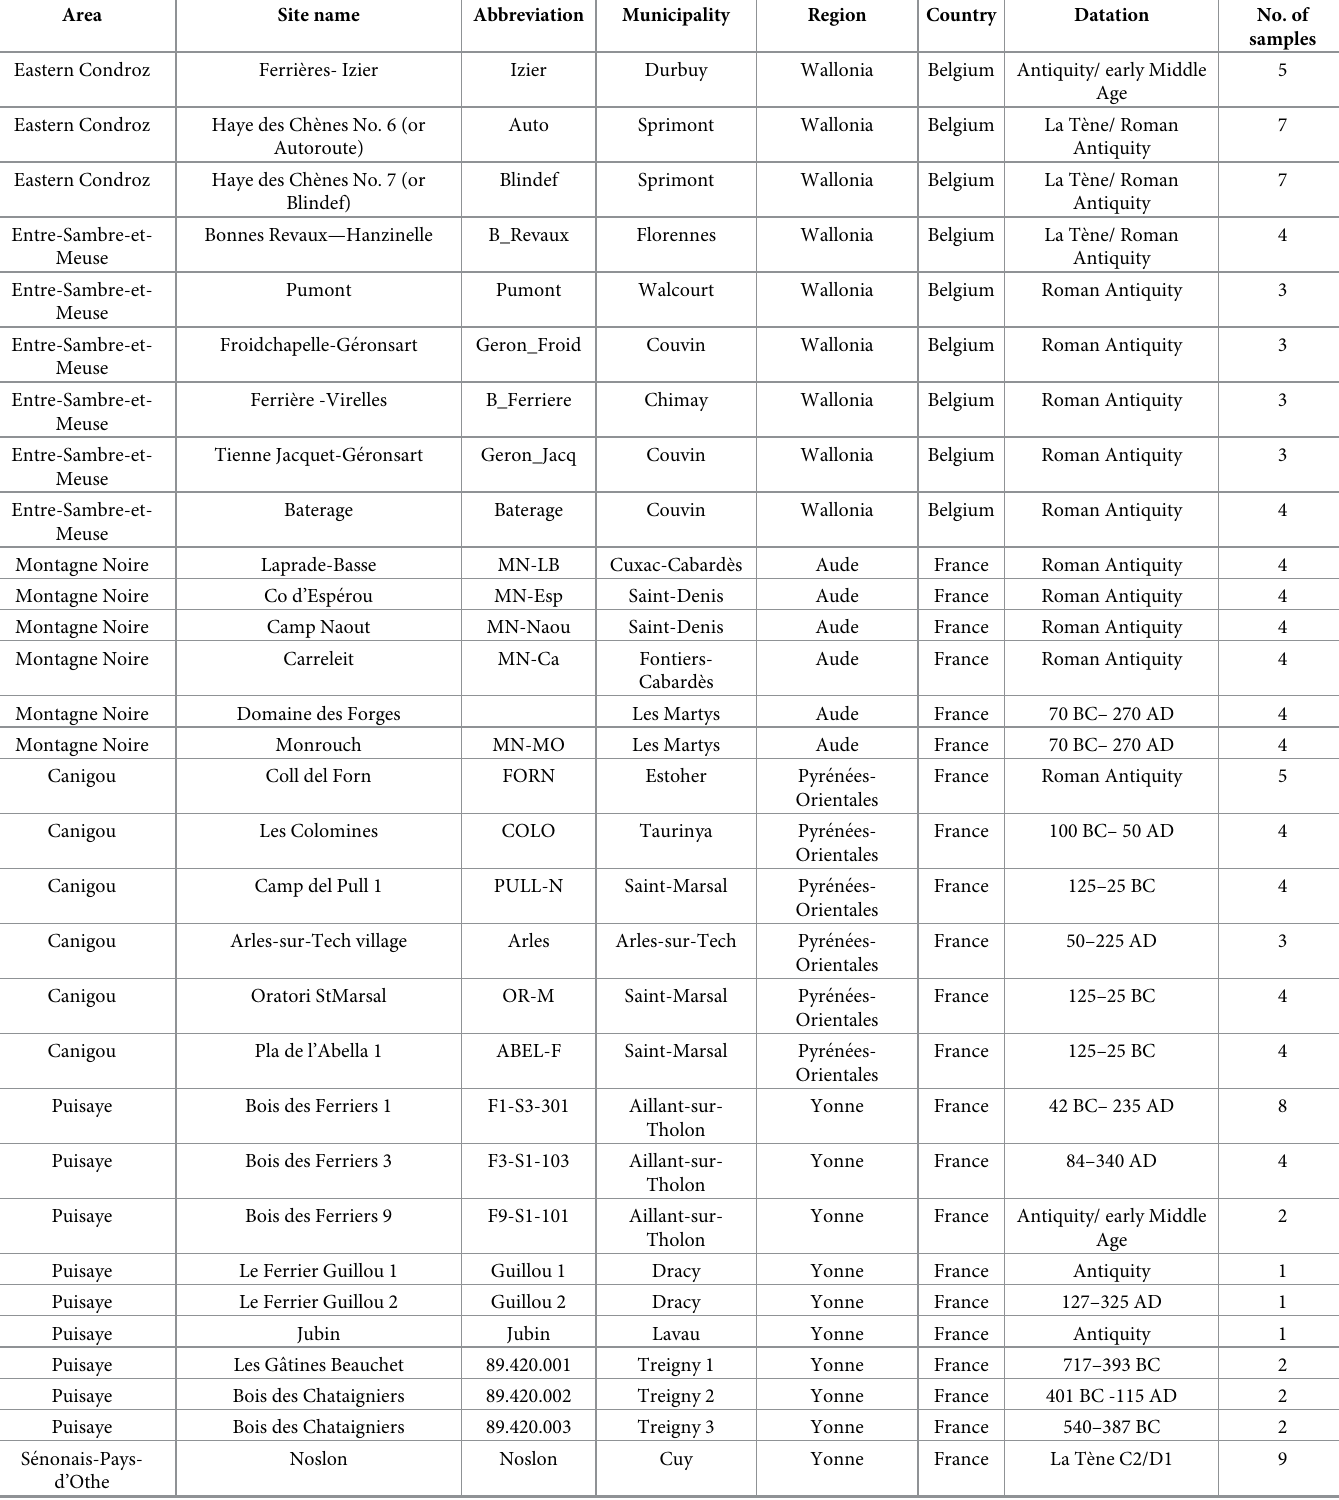
Table 1. Slag samples from the production